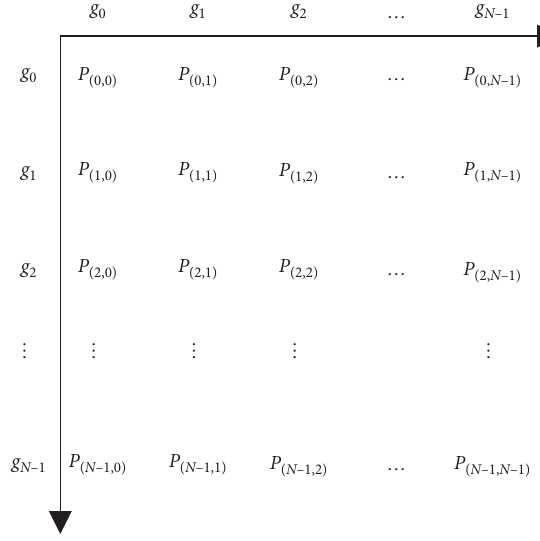
Figure 8: The structure of the